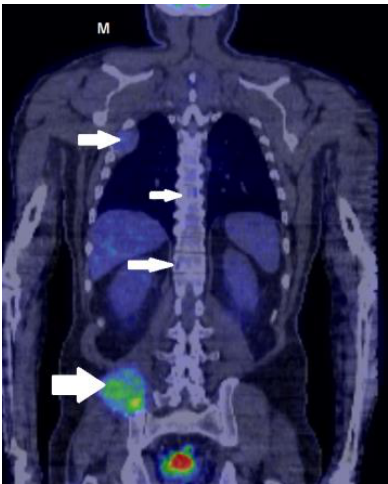
Figure 5. The whole-body PET-CT showed (arrow) the activated metabolism of a 10 to 7.5 cm mass in the right iliac wing that invaded the neighboring endo- and exopelvic structures. The mass showed an inhomogeneous uptake of FDG. Other similarly moderate FDG-capturing osteolytic lesions could be distinguished in T7 and T9 vertebral bodies, the right lateral clavicular extremity, and the right humeral